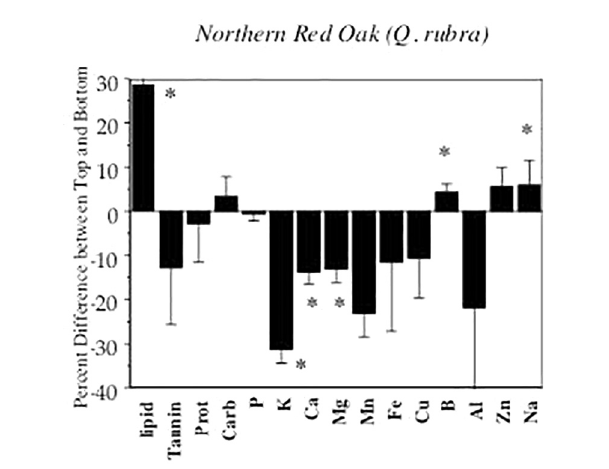
FIGURE 1 | From Steele, Michael A., Oak Seed Dispersal: A Study in Plant Animal Interactions. Figure 6 .8b. @ 2021 Johns Hopkins University Press. Modified and reprinted with permission of Johns Hopkins University Pr ess. (A) Distinction of the cotyledon of basal (top) and apical (bottom) halves of northern red oak acorns based on levels of lipid, tannin, carbohydrates, protein and 8 minerals. Results are based on composite samples of top and bottom halves of acorns from each of 20 trees (Steele, in press). Although tannin alone is not significantly higher in apical halves in this analysis (but see Steele et al., 1993), lipid and Na is higher in the basal half, suggesting that the top is more palatable but also higher in energy. Throughout the literature, it is now known that a suite of acorn seed predators (e.g., squirrels and other rodents, birds, and insect larvae) selectively consume the basal half of acorns and discard the apical halves, along with the embryo (Steele et al., 1993; Perea et al., 2011; Yang and Yi, 2012; Steele, in press), and that these damaged acorns can still germinate and establish (Steele, in press). ∗ indicates significant difference in top and bottom halves at P < 0.05.